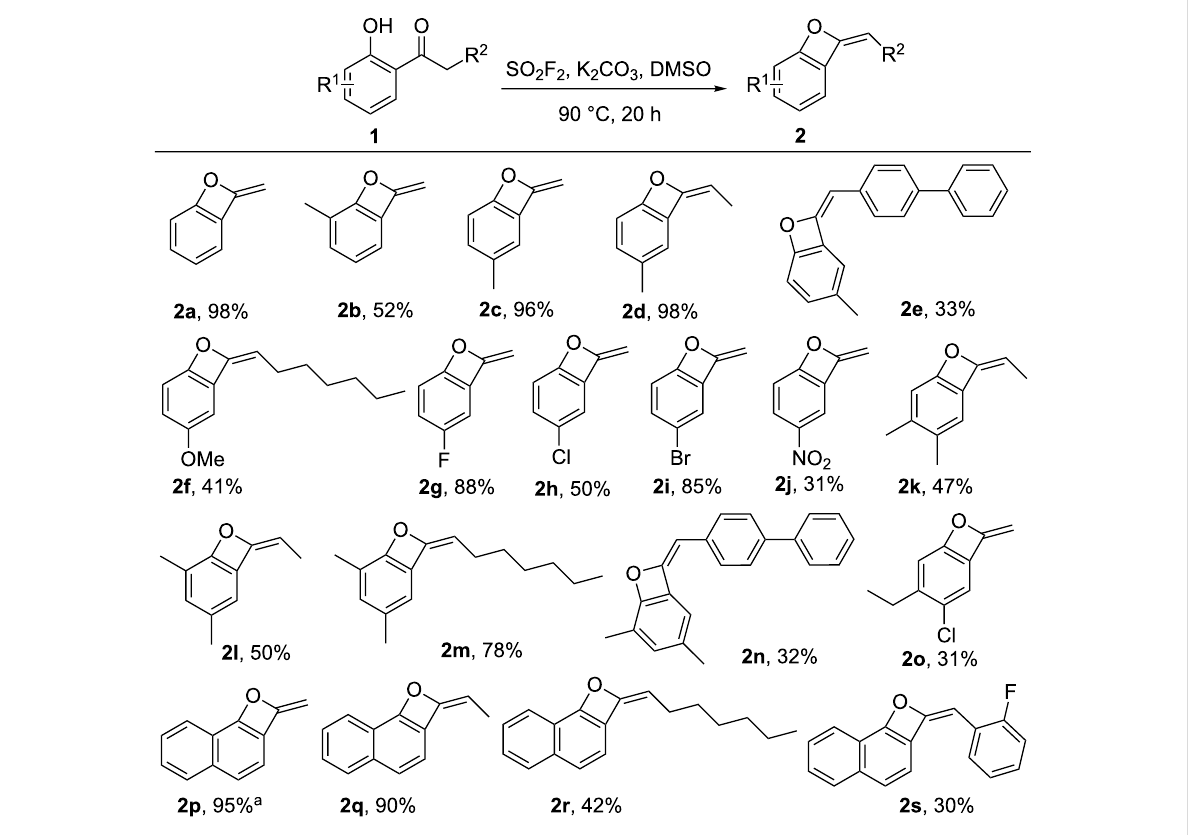
sphere (balloon) for 20 h. Yields refer to isolated yields. a Reaction performed at 50 °C.